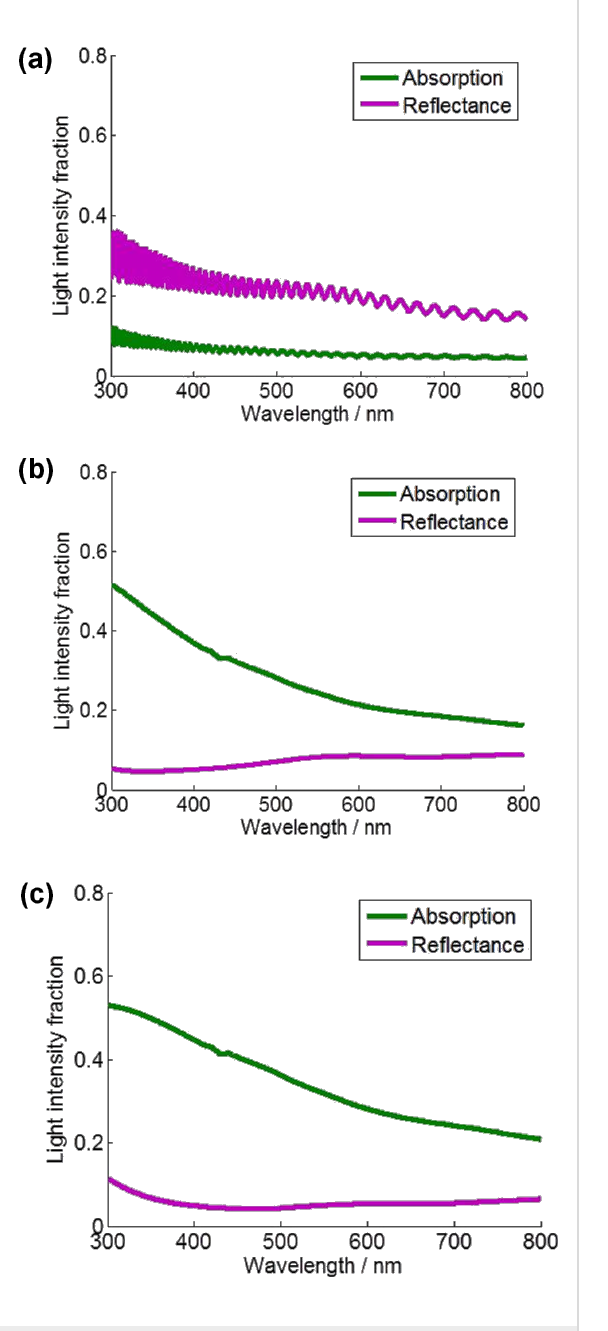
Figure 6: Calculated absorption and reflectance of the DSSCs with different TNT lengths by using GTMM: (a) 3.3 μ m long TNT array, (b) 11.5 μ m long TNT array, and (c) 20.6 μ m long TNT array.